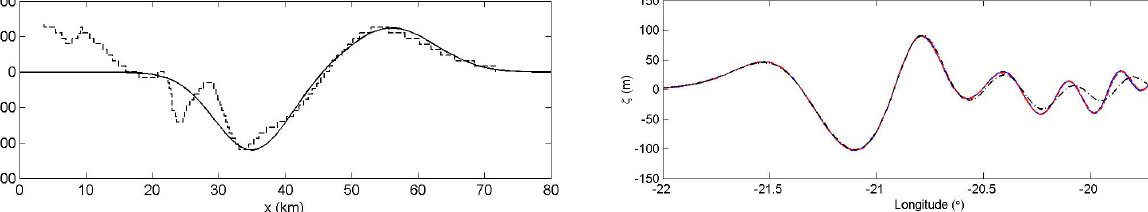
Fig. 18. Water surface profile depicted with Eq. (7) (—) and that in Gisler et al.’s (2006) numerical scenario Cth31 (- -), digitalized from Løvholt et al.’s (2008) Fig. 3.